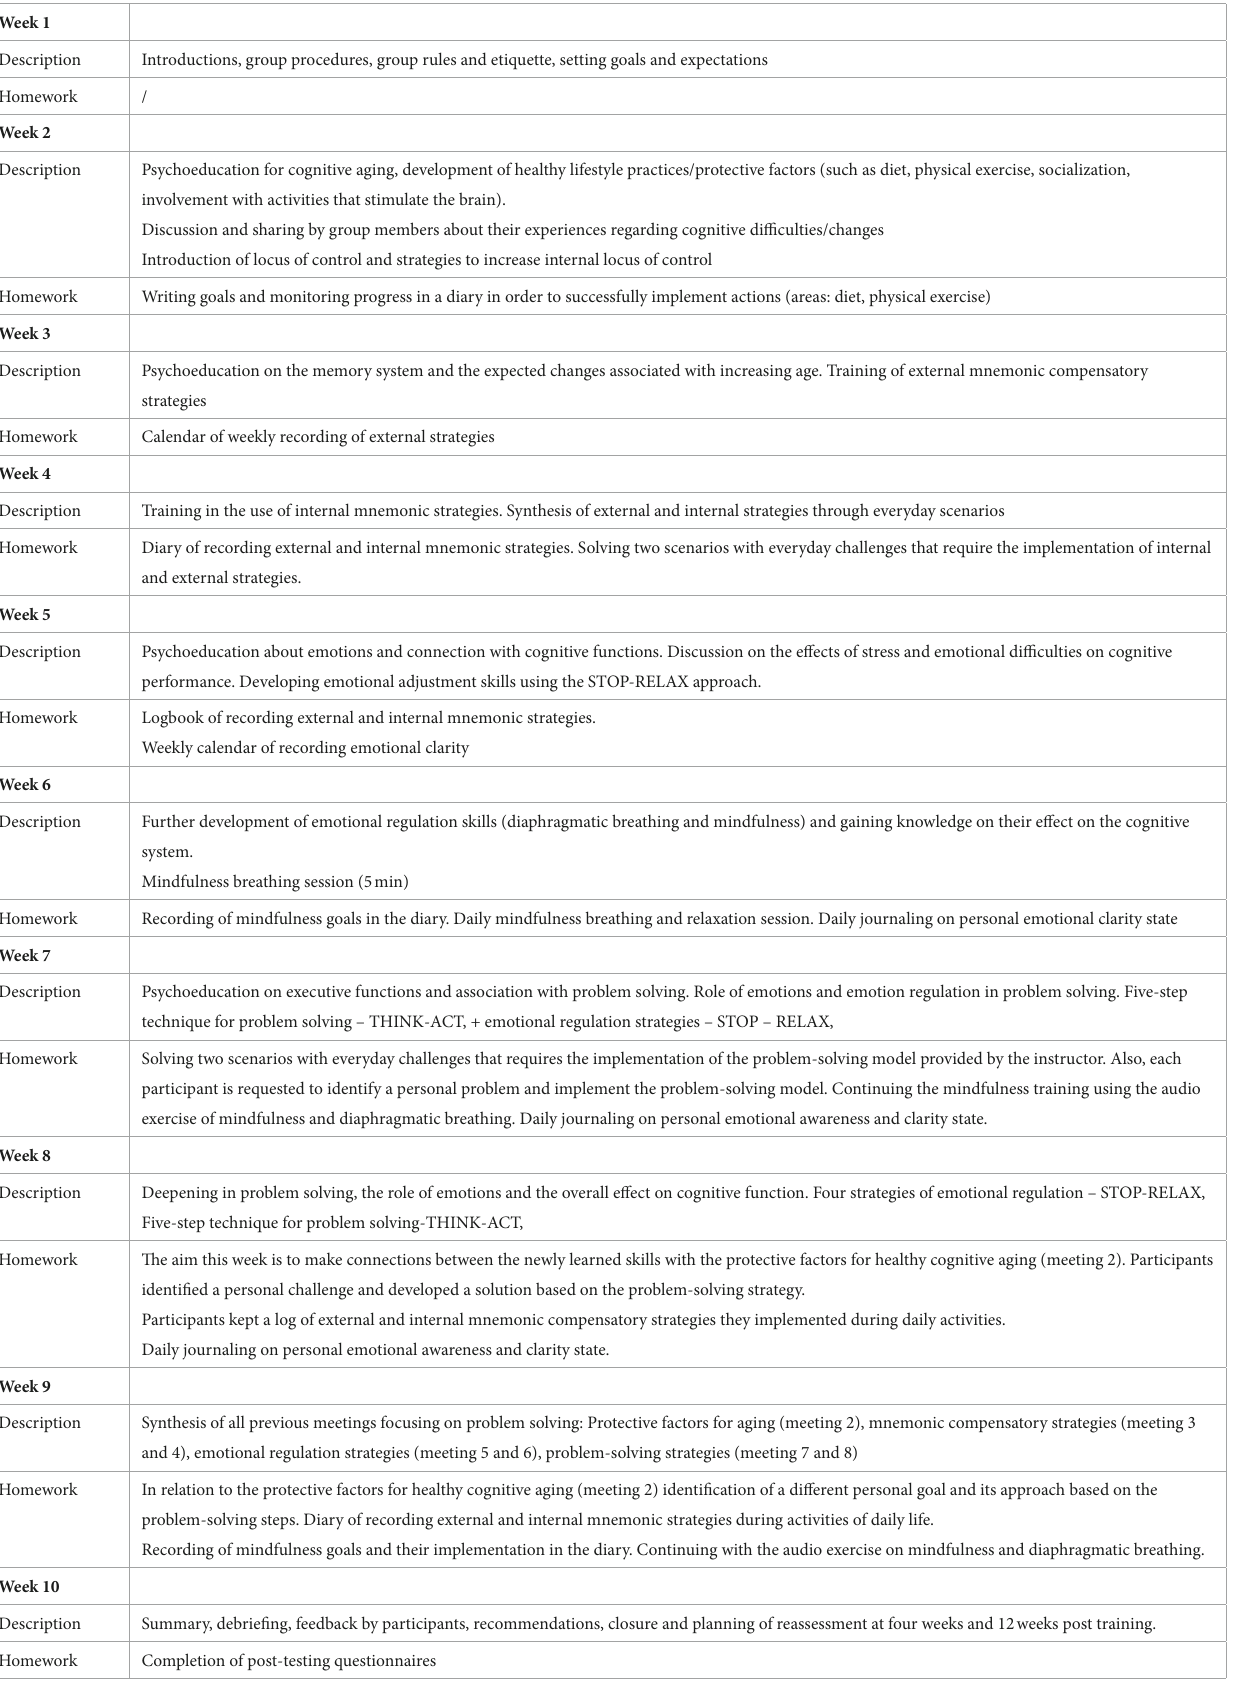
TABLE 1 The main axes of the meetings of the intervention